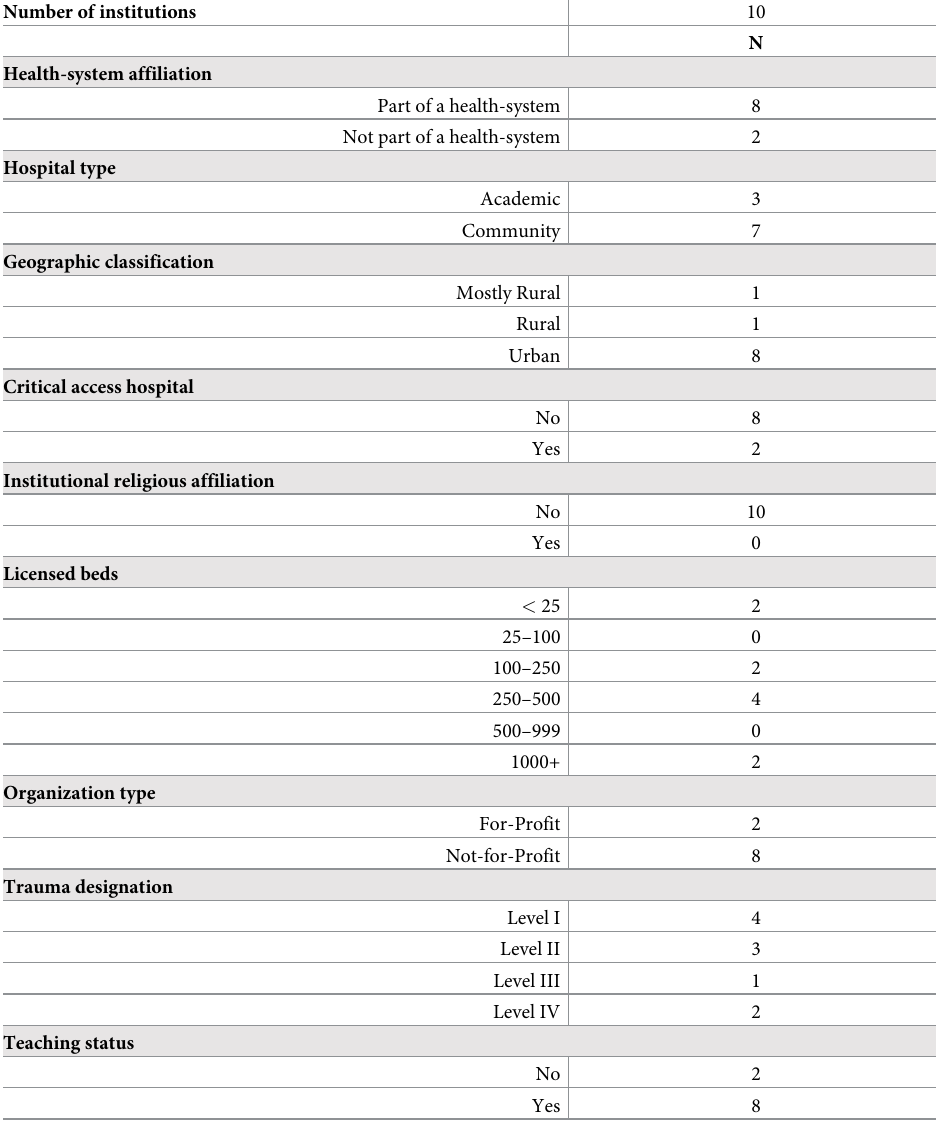
Table 1. Hospital